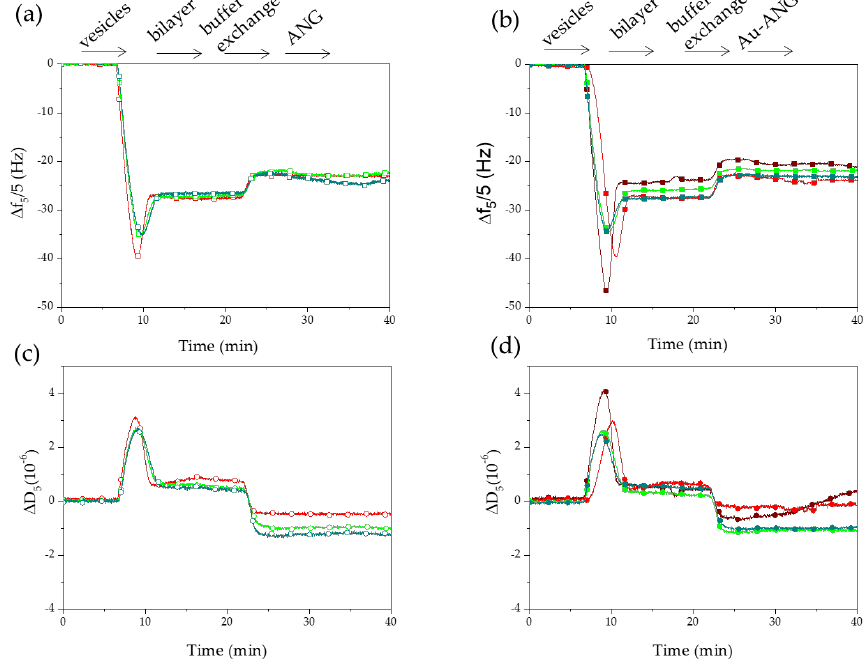
Figure 5. QCM-D curves of frequency ( a , b ) and dissipation ( c , d ) shifts corresponding to the fifth overtones ( n = 5) for POPC SUVs adsorption followed by the addition of 5 × 10 −8 M free proteins (open symbols; wtANG = red; rANG = green; S28CANG = dark cyan) or AuNP-based systems (solid symbols; 2.3 × 10 7 NP/mL citrate-capped bare nanoparticles = wine; 2.5 × 10 6 NP/mL Au-wtANG = red; 1.6 × 10 6 NP/mL Au-rANG = green; 1.6 × 10 6 NP/mL Au-S28CANG = dark cyan. Experiments were performed in 1 mM MOPS buffer (pH = 7.4).